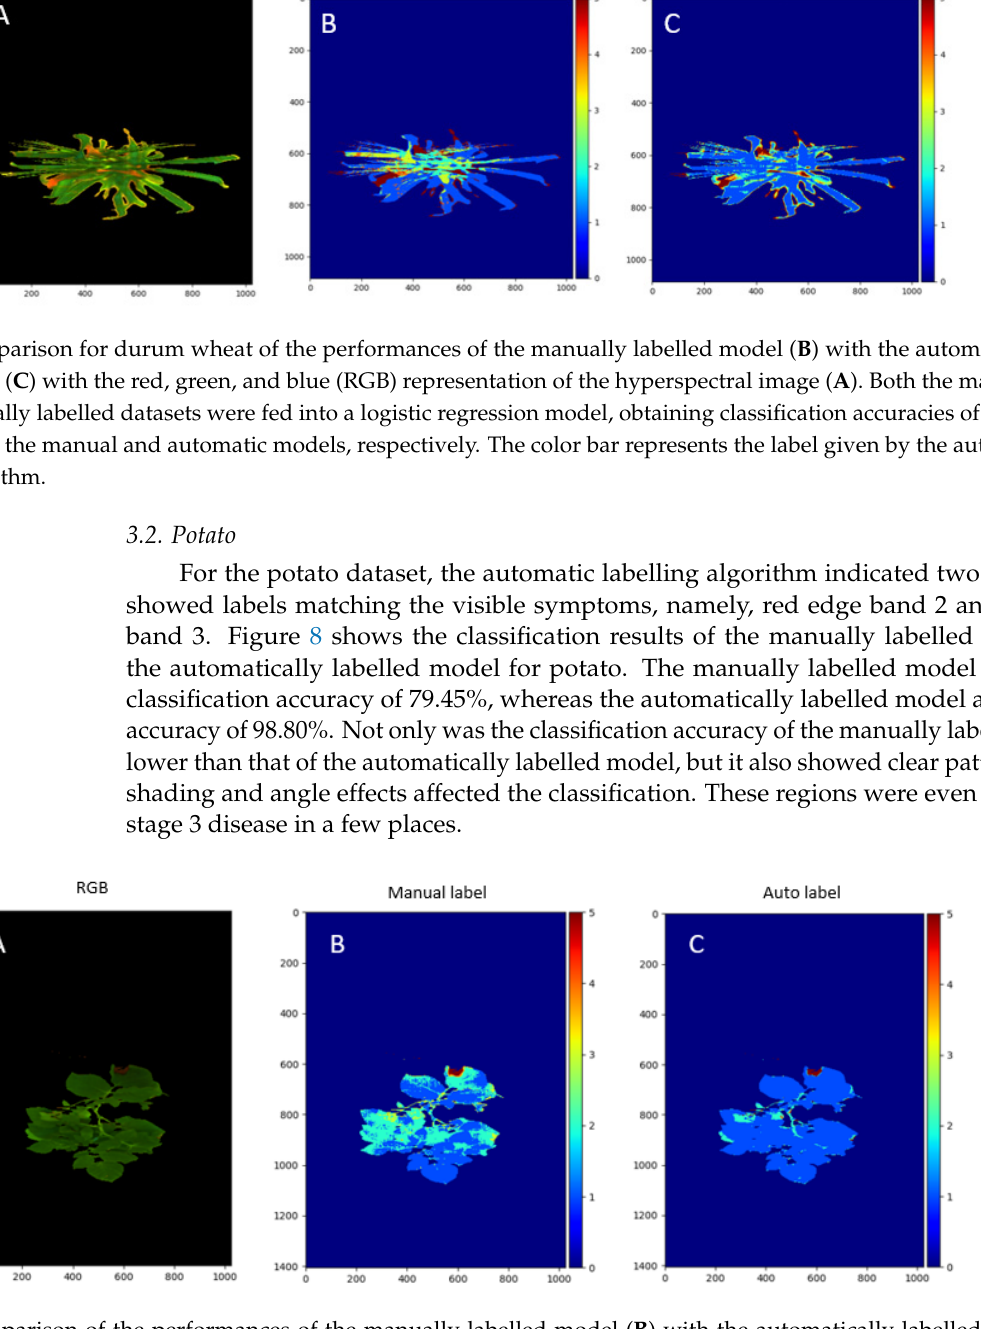
Figure 8. Comparison of the performances of the manually labelled model ( B ) with the automatically labelled model ( C ) with the red, green, and blue (RGB) representation of the hyperspectral image ( A ). Both the manually and automatically labelled datasets were fed into a logistic regression model with classification accuracies of 79.45% and 98.80% for the manual and automatic models, respectively. The color bar represents the label given by the automatic labelling algorithm.